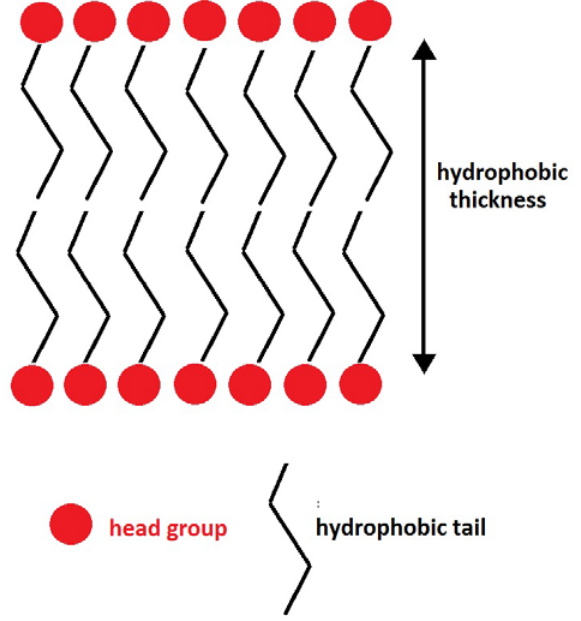
Figure 2. Schematic representation of a lipid bilayer and hydrophobic thickness.